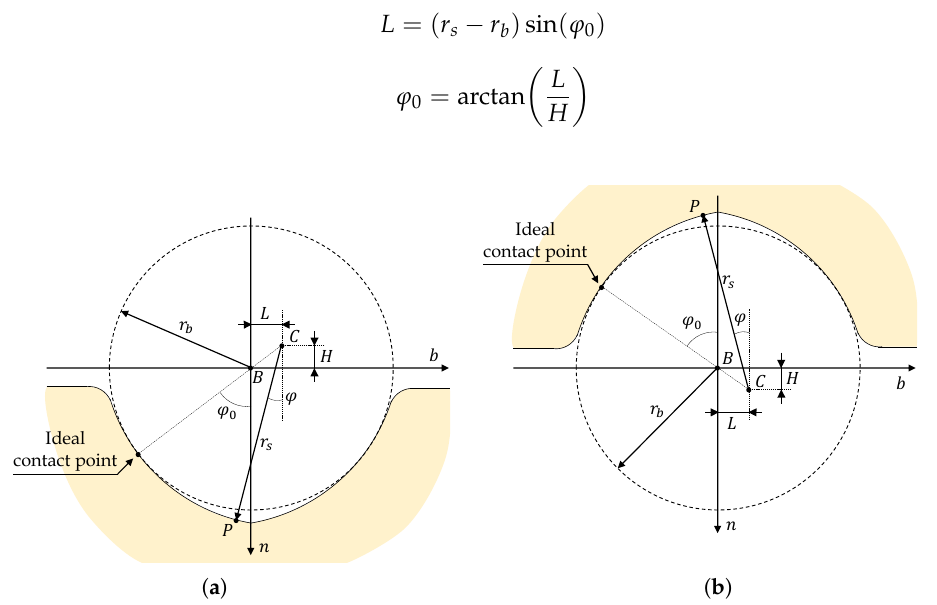
Figure 2. Groove’s gothic arch profile of the ( a ) screw shaft and ( b ) nut on the n − b plane of the Frenet–Serret reference